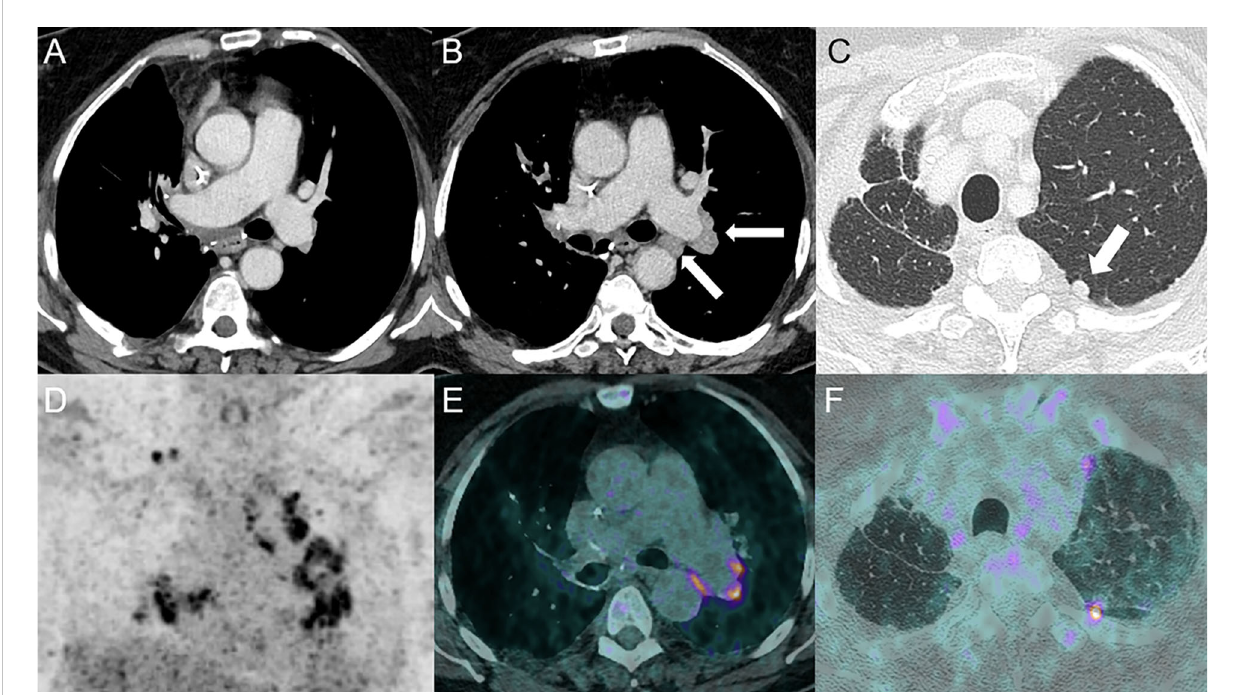
FIGURE 4 Sarcoidosis-like reaction in a 69-year-old female with stage IIIa lung adenocarcinoma in the right upper lobe treated by neoadjuvant cisplatin- docetaxel followed by durvalumab (anti-PD-L1) with subsequent right upper lobe lobectomy and lymphadenectomy. The patient received adjuvant durvalumab 1 month post-surgery. Baseline CT following surgery is shown in (A) . Follow-up CT at 5 months showed the development of bilateral hilar and mediastinal lymphadenopathies [arrows, (B) ] and an increasing nodule in the left upper lobe (arrow) (C) . 18 F-FDG PET-CT con fi rmed high uptake of mediastinal and hilar lymph nodes [PET (D) and fused PET/CT (E) images] and the upper left lobe nodule [fused PET/CT images (F) ]. A wedge resection con fi rmed the sarcoidosis-like nature of the